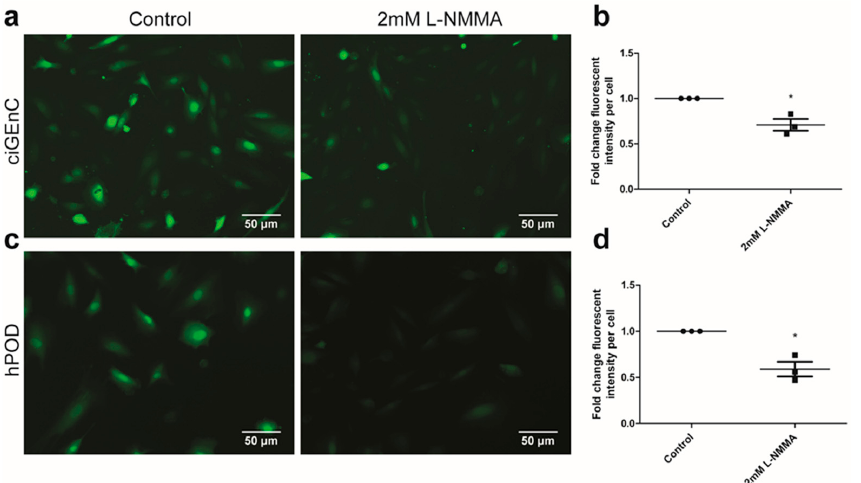
Figure 1. ciGEnC and hPOD synthesize NO. ciGEnC and hPOD were stained with 5 µM DAF-FM diacetate upon their respective differentiation period. ( a ) Representative images are shown from the ciGEnC left untreated (left panel) or treated with the NOS inhibitor L-NMMA (2 mM) (right panel). ( b ) Quantification of the fold change in the fluorescent intensity of the area * mean fluorescent intensity per cell for ciGEnC. ( c ) Representative images are shown from the hPOD left untreated (left panel) or treated with the NOS inhibitor L-NMMA (2 mM) (right panel). ( d ) Quantification of the fold change in the fluorescent intensity of the area * mean fluorescent intensity per cell for hPOD. * p < 0.05.